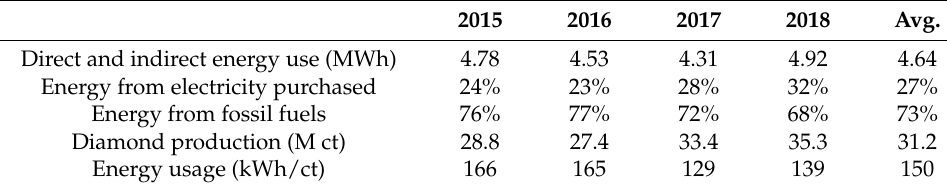
Table 2. Total energy use of DeBeers Group 2015–2018 1 [20,21].